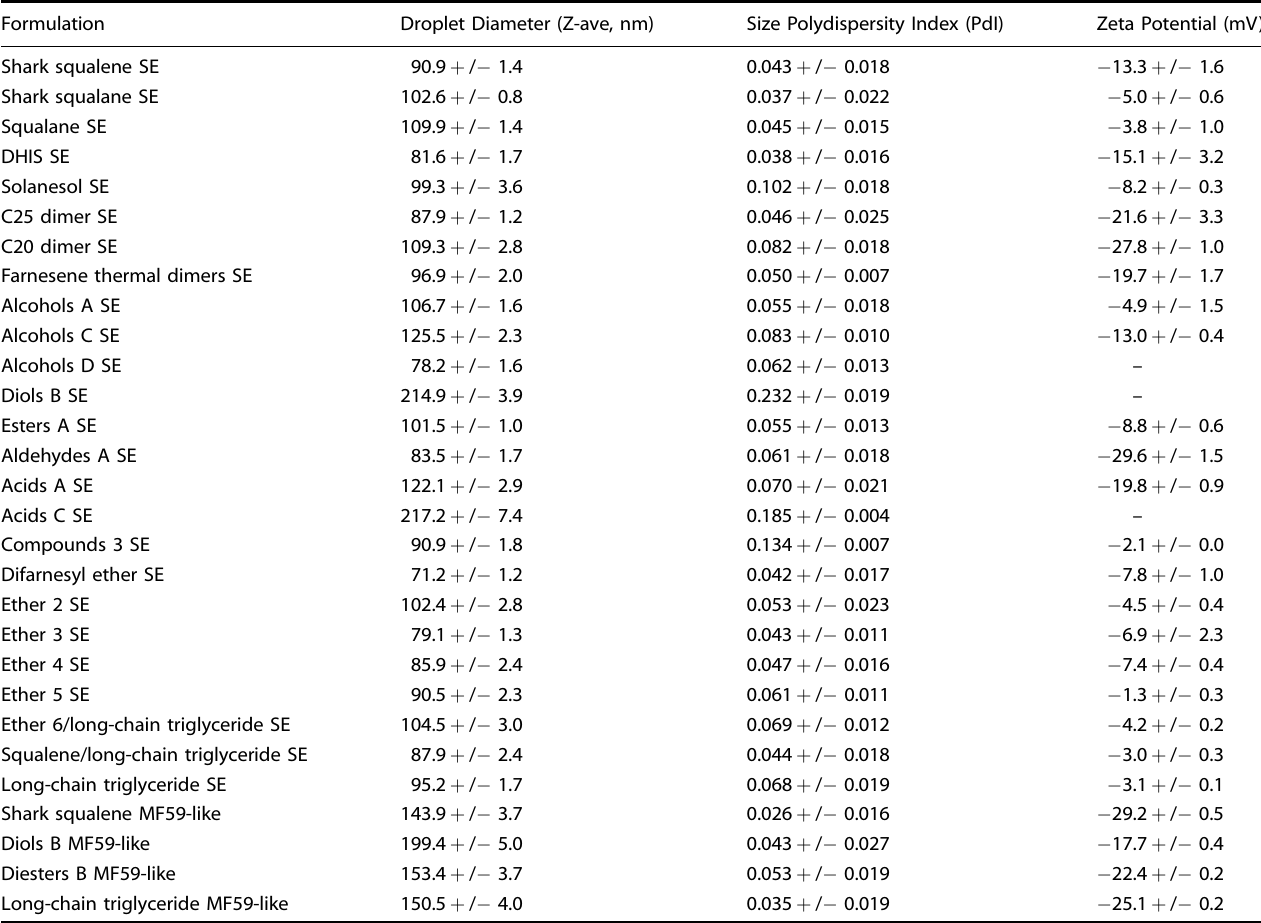
Table 2. Emulsion physical